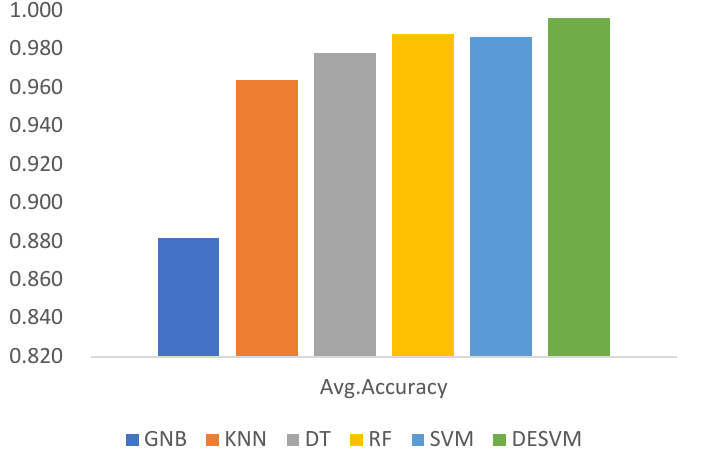
Figure 8. Comparison of algorithm’s accuracy evaluation by ten-fold hierarchical cross-validation. The confusion matrix of the recognition results for each machine learning algorithm is shown in Figure 9. The vertical axis represents the truth, and the horizontal axis represents the output of the classification. The labels correspond to the test objects.